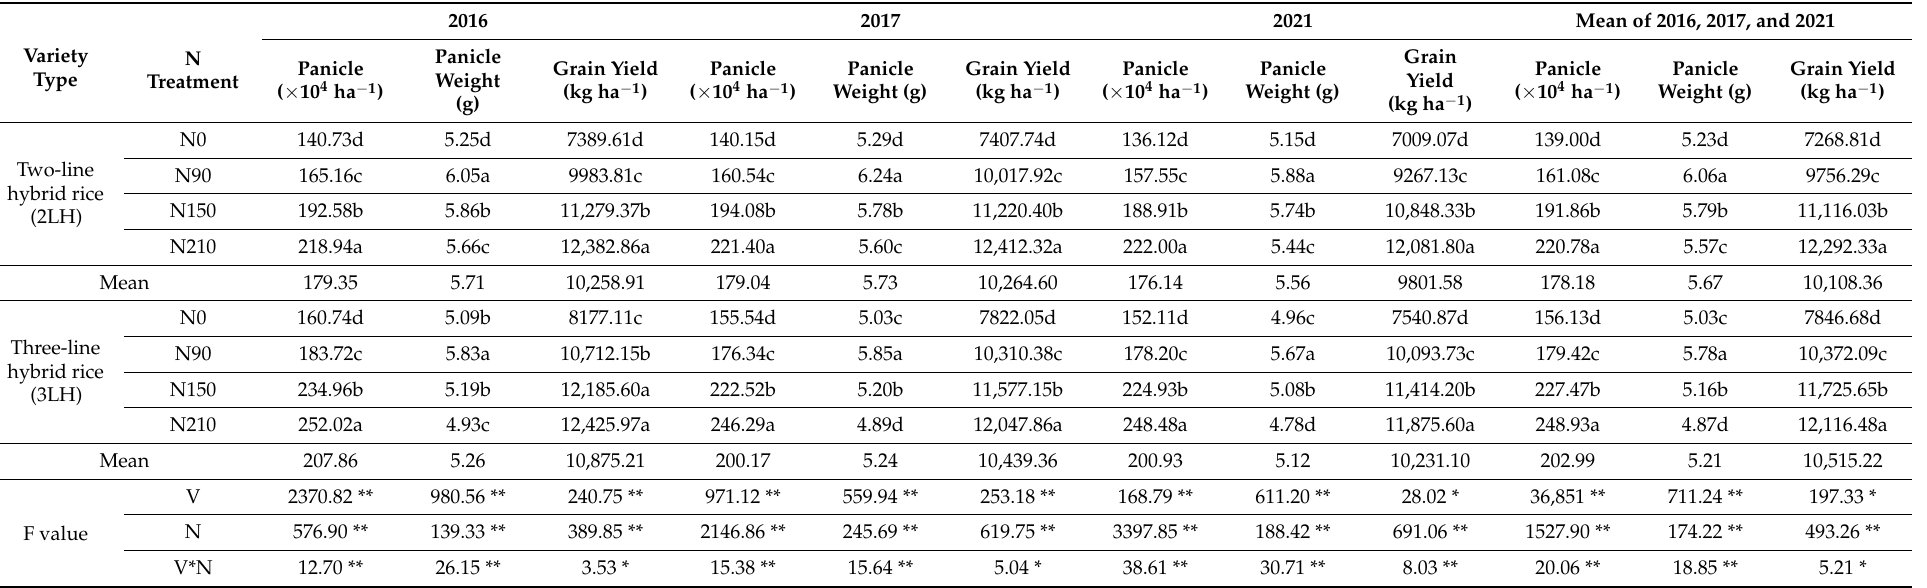
Table 4. Effects of N rates on grain yield and yield components of two rice